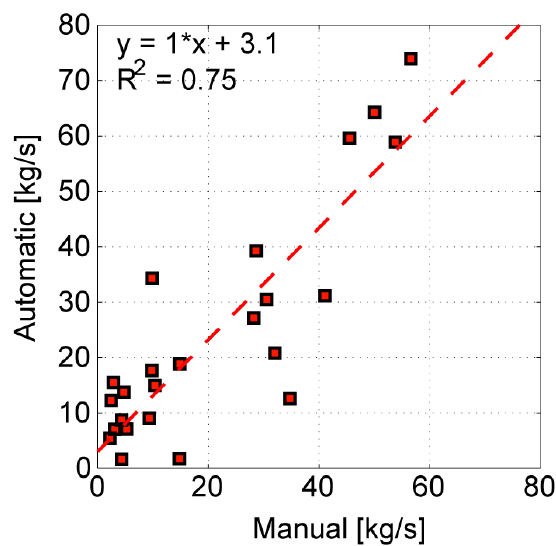
Figure 6. Comparison between daily averaged SO 2 fluxes calculated by a manual operator (using Vulcamera software, [33]) and those obtained by the automatic algorithm. The correlation coefficient between the two datasets is 0.75, with a 1:1 proportionality ratio. This correlation validated the automatic algorithm as an alternative, reliable method for SO 2 flux calculation.